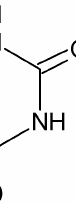
Figure 1. Chemical structure of 5-fluorouracil.